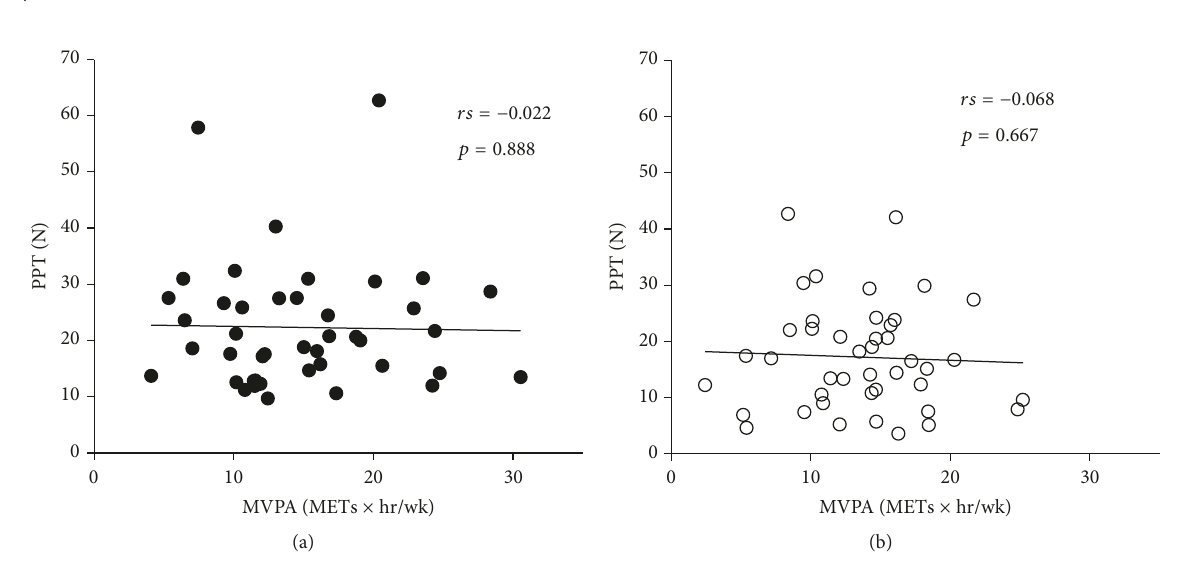
Figure 1: Correlation between PPT and MVPA among (a) men and (b) women. PPT: pressure pain threshold; MVPA: moderate-to-vigorous physical activity.